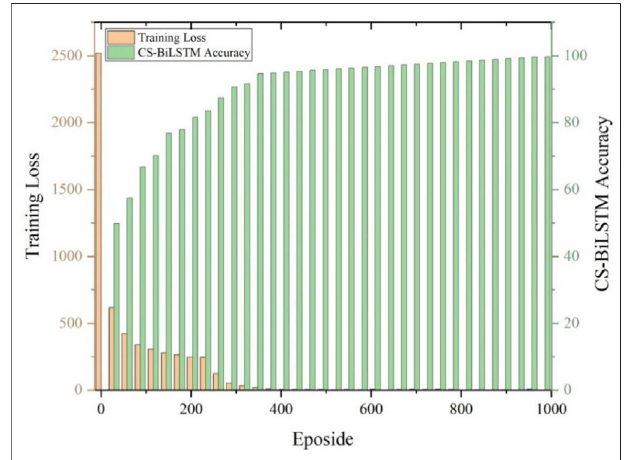
FIGURE 11 | Training loss and classi fi cation accuracy of the optimized CS-BiLSTM model.